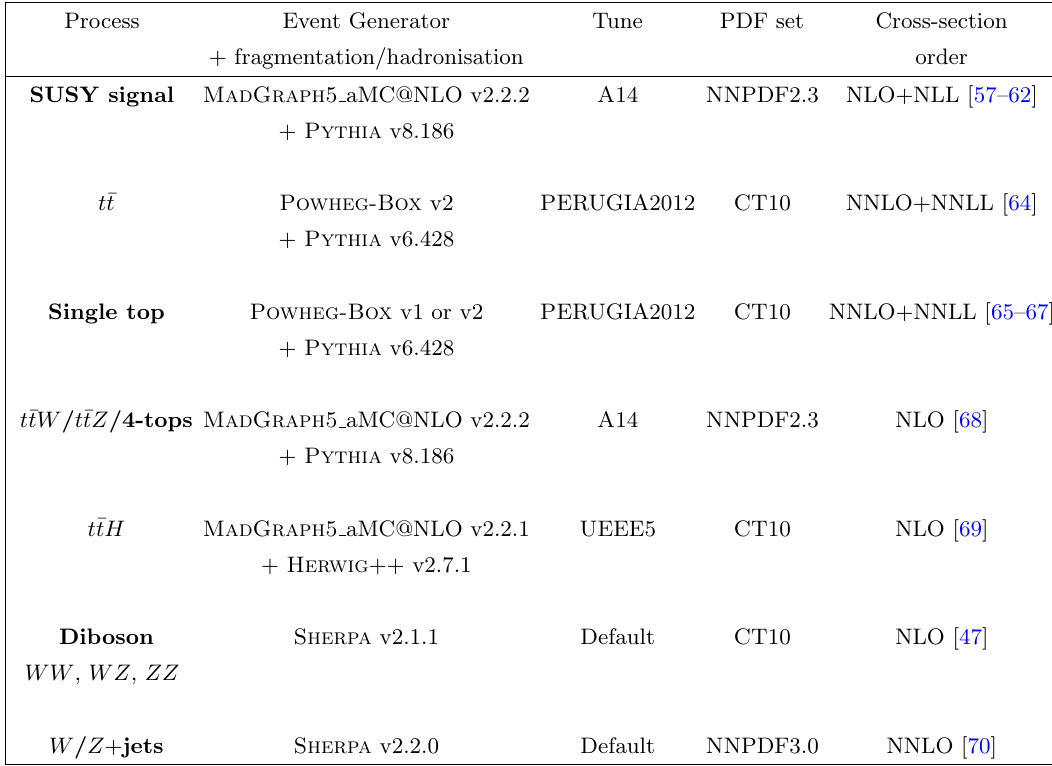
Table 1. List of event generators used for the di(cid:11)erent processes. Information is given about the underlying-event tunes, the PDF sets and the pQCD highest-order accuracy used for the normali- sation of the di(cid:11)erent